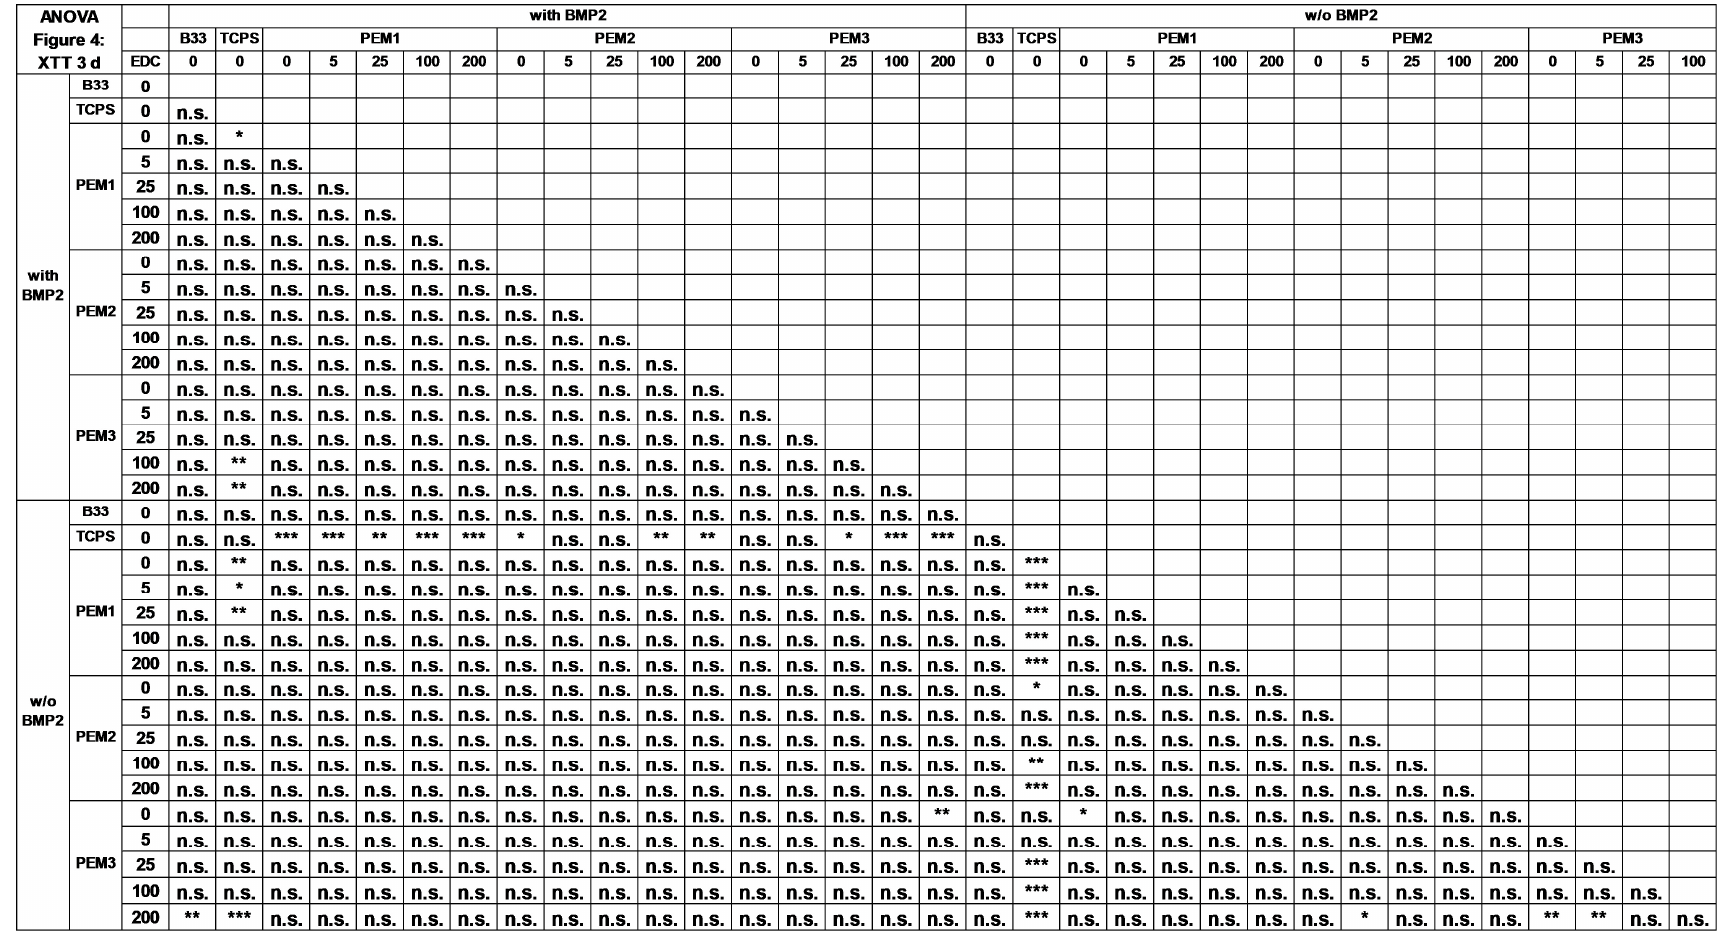
Figure A3. Results of one-way ANOVA for data related to Figure 4 (3 d); n.s.: not significant; *: p < 0.1; **: p < 0.05; ***: p < 0.001.